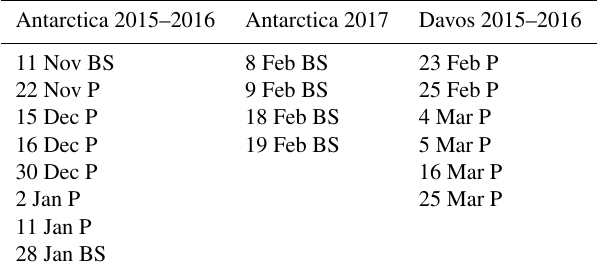
Table 1. Campaigns and dates of selected events for the blowing snow (BS) and precipitation (P) subsets.